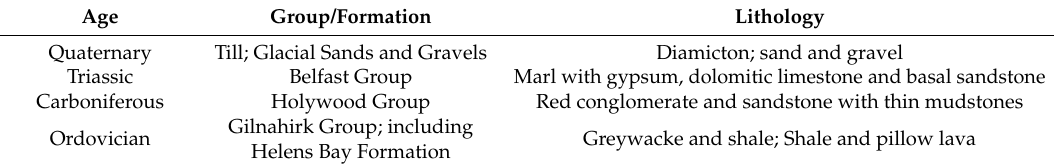
Table 2. Reference summary geology along the Bangor to Hollywood Railway